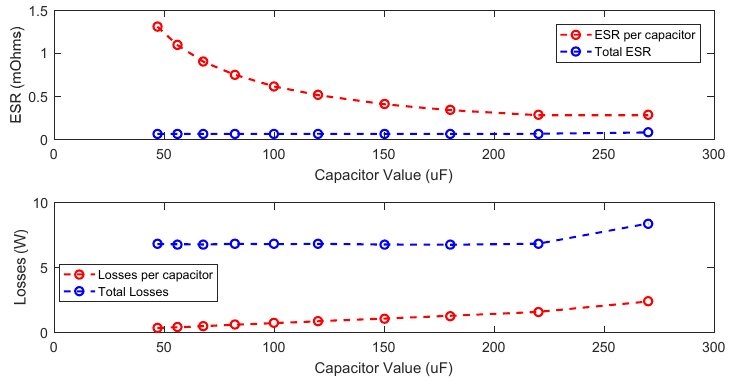
Figure 3. ESR and losses according to the capacitor value.